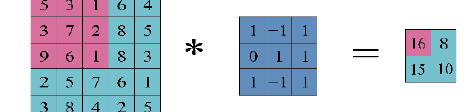
Figure 2. Convolution operation of 2DCNN.